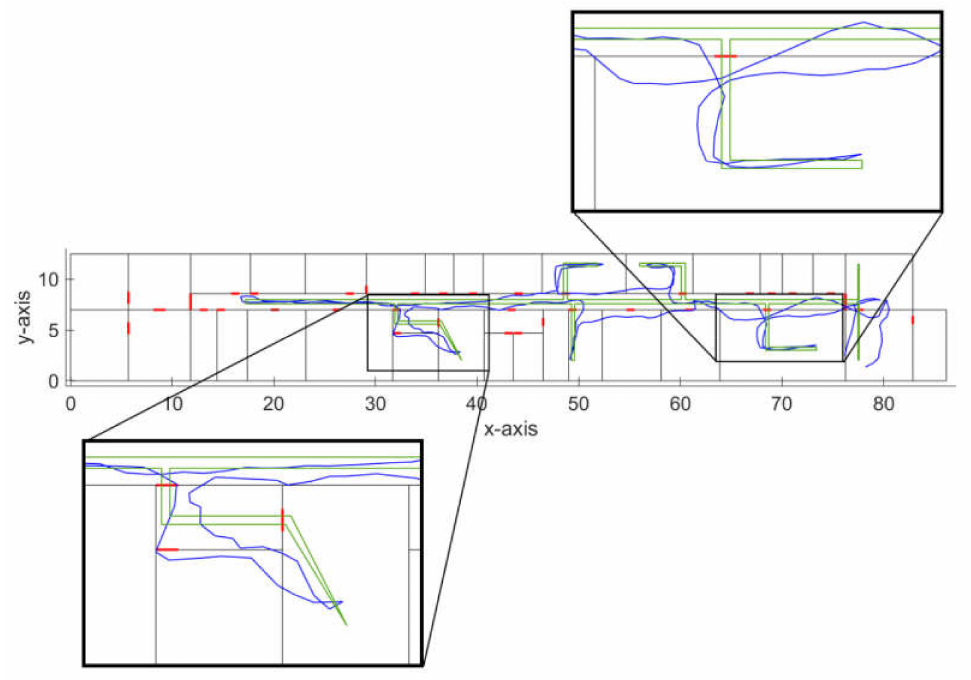
Figure 5. Detailed view of errors of the recovered